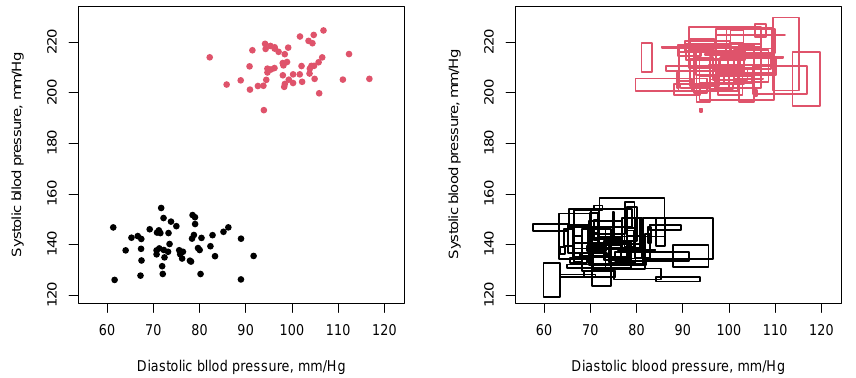
Figure 1. Artificial data generated by two bi-variate Normal distributions. To the left we have a dataset in an ordinary form; to the right, we have an interval-valued